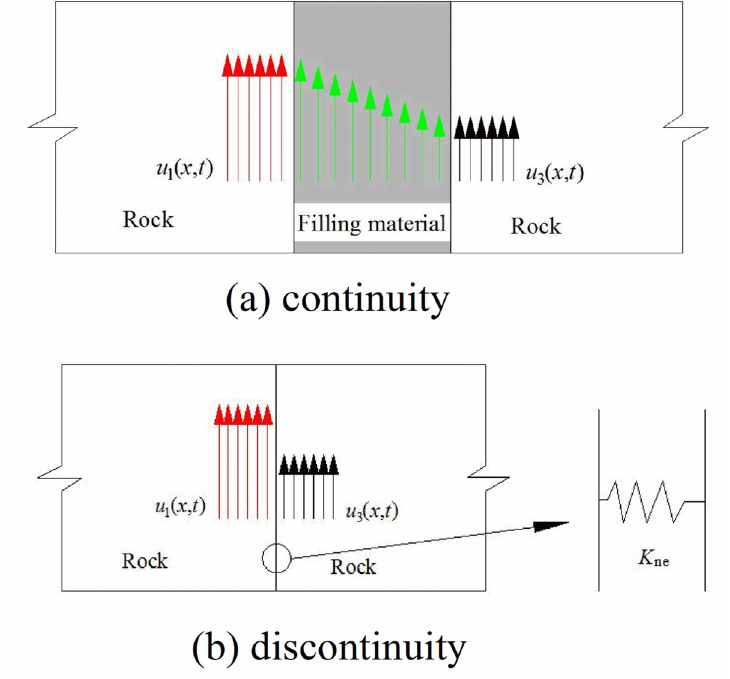
Fig 3. Schematic view of the displacement at the filled joint. (a) Continuity (b) Discontinuity.